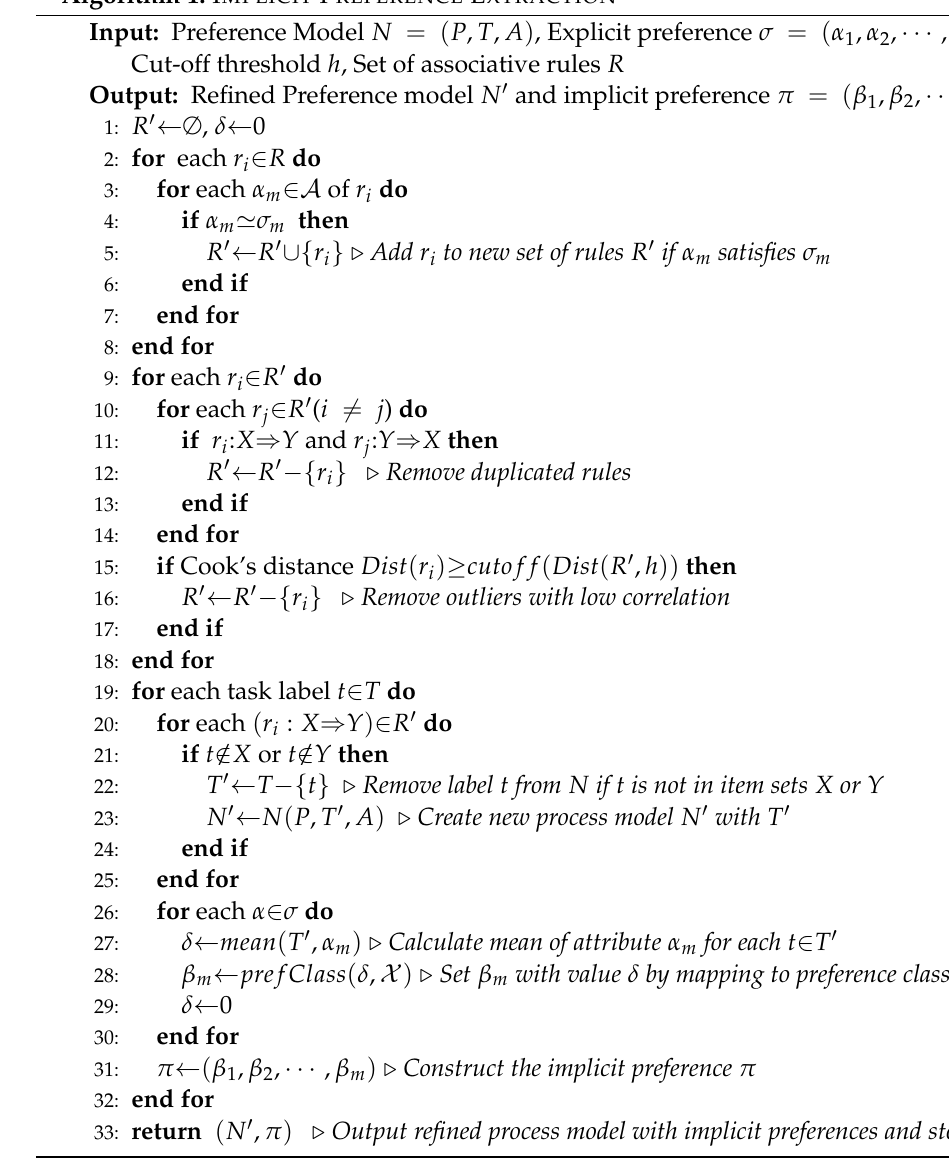
Algorithm 1: I MPLICIT P REFERENCE E